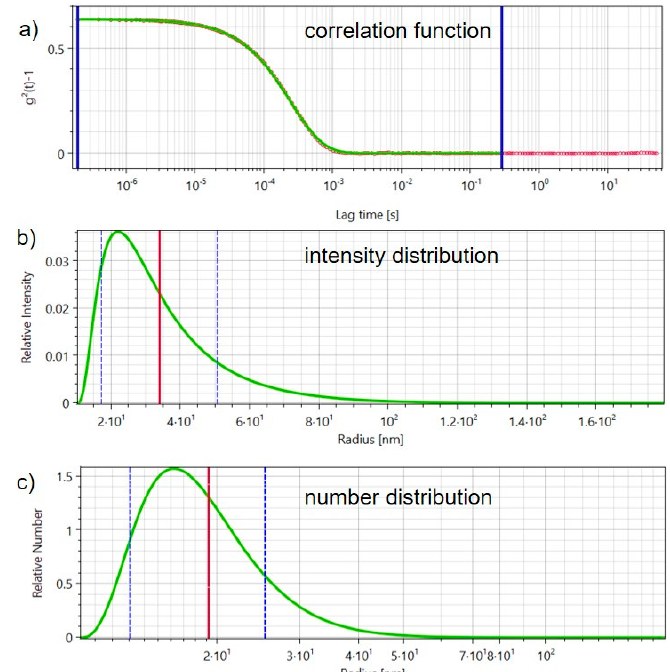
Figure 1. Gold nanospheres, an example of a single measurement and CORENN analysis is shown (concentration 0.0016 mg/mL): ( a ) Measured intensity correlation function with CORENN − fit (red circles: measured signal; green: CORENN − fit, blue vertical lines: lower and upper limit of the time used for the fit) ; ( b ) intensity distribution, ( c ) number distribution of the hydrodynamic radii (green curces) Average values from the distributions ( b , c ) are indicated as vertical red line, the dashed blue lines indicate the interval of the standard